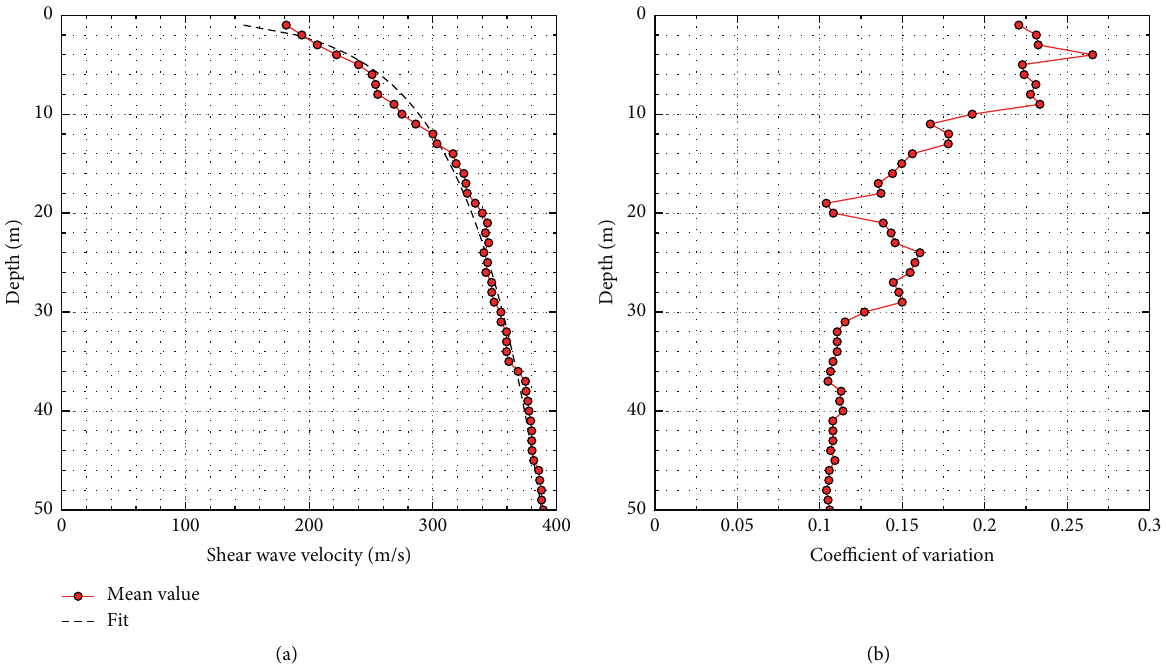
Figure 12: (a) Mean shear wave velocity as a function of the depth for boreholes in Bucharest area. (b) Coefficient of variation of the shear wave velocity as a function of the depth for boreholes in Bucharest area.